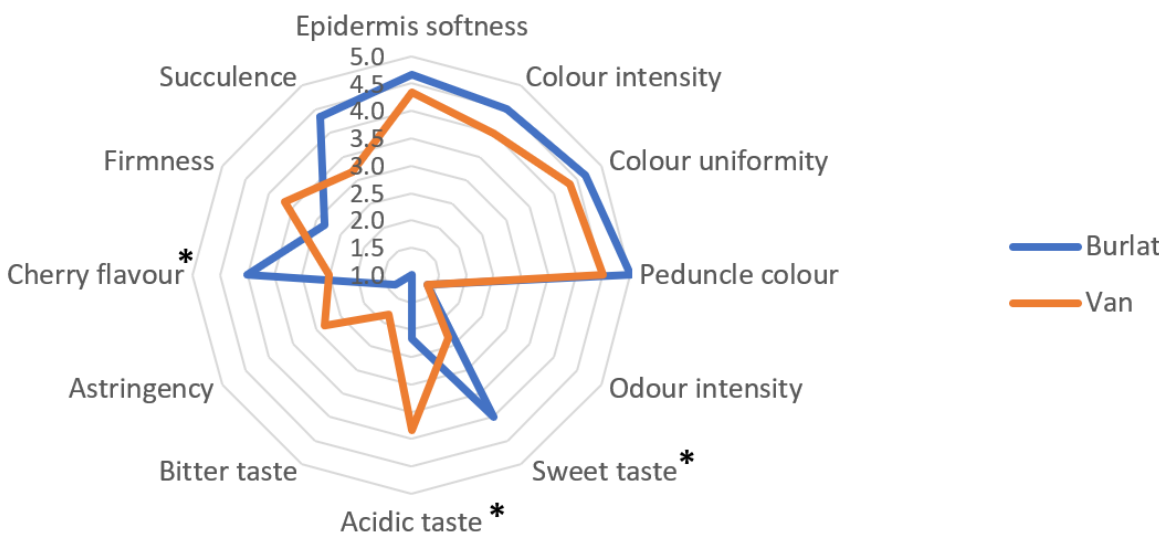
Figure 5. Spider plot of the sensory profile of the two sweet cherry cultivars (Van and Burlat). (*) represented significant differences between cultivars, according to Duncan’s test, p < 0.05. The absence of superscript indicated no significant differences.